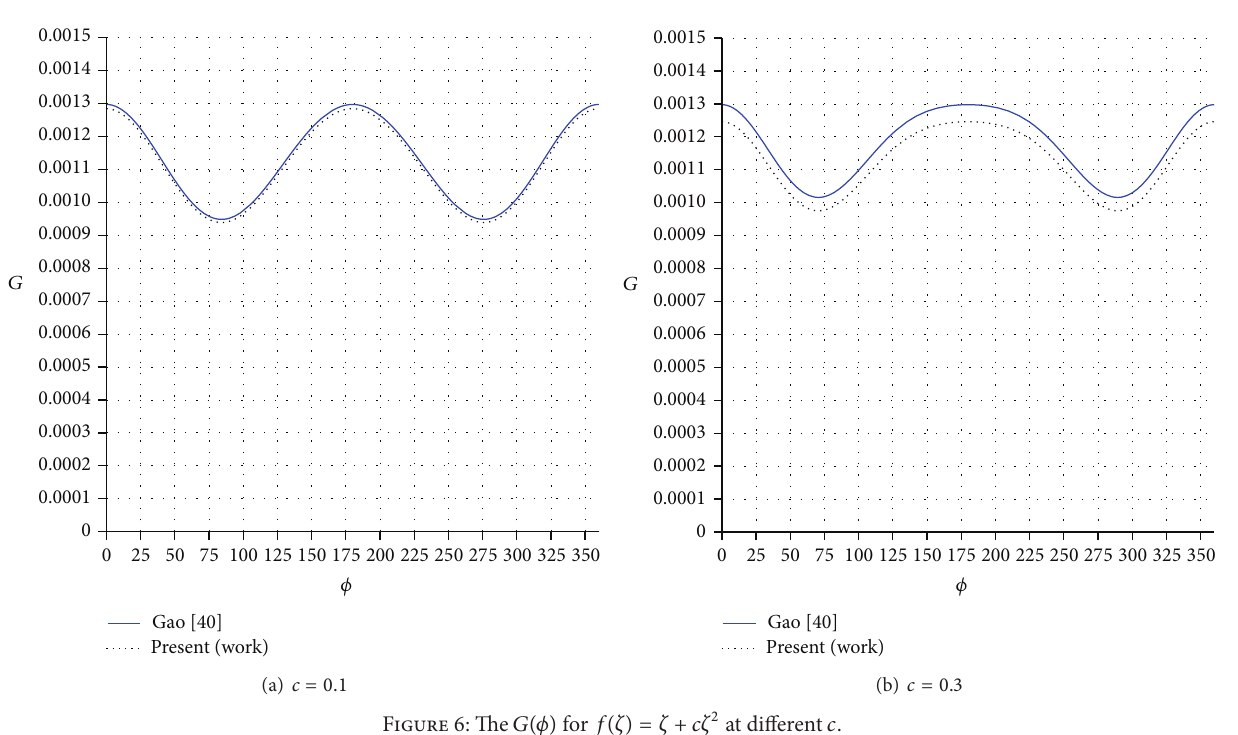
Figure 6: The 𝐺(𝜙) for 𝑓(𝜁) = 𝜁 + 𝑐𝜁 2 at different 𝑐